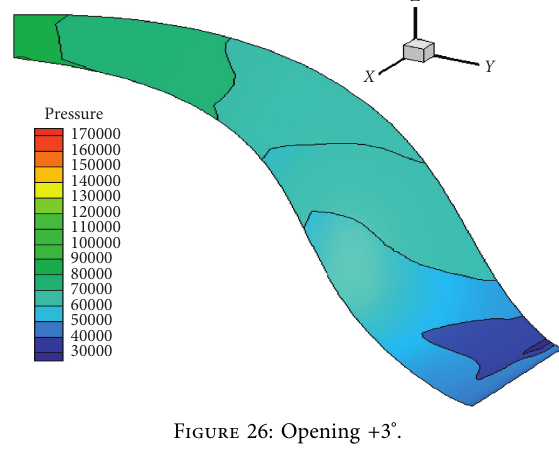
Figure 26: Opening +3 ° .